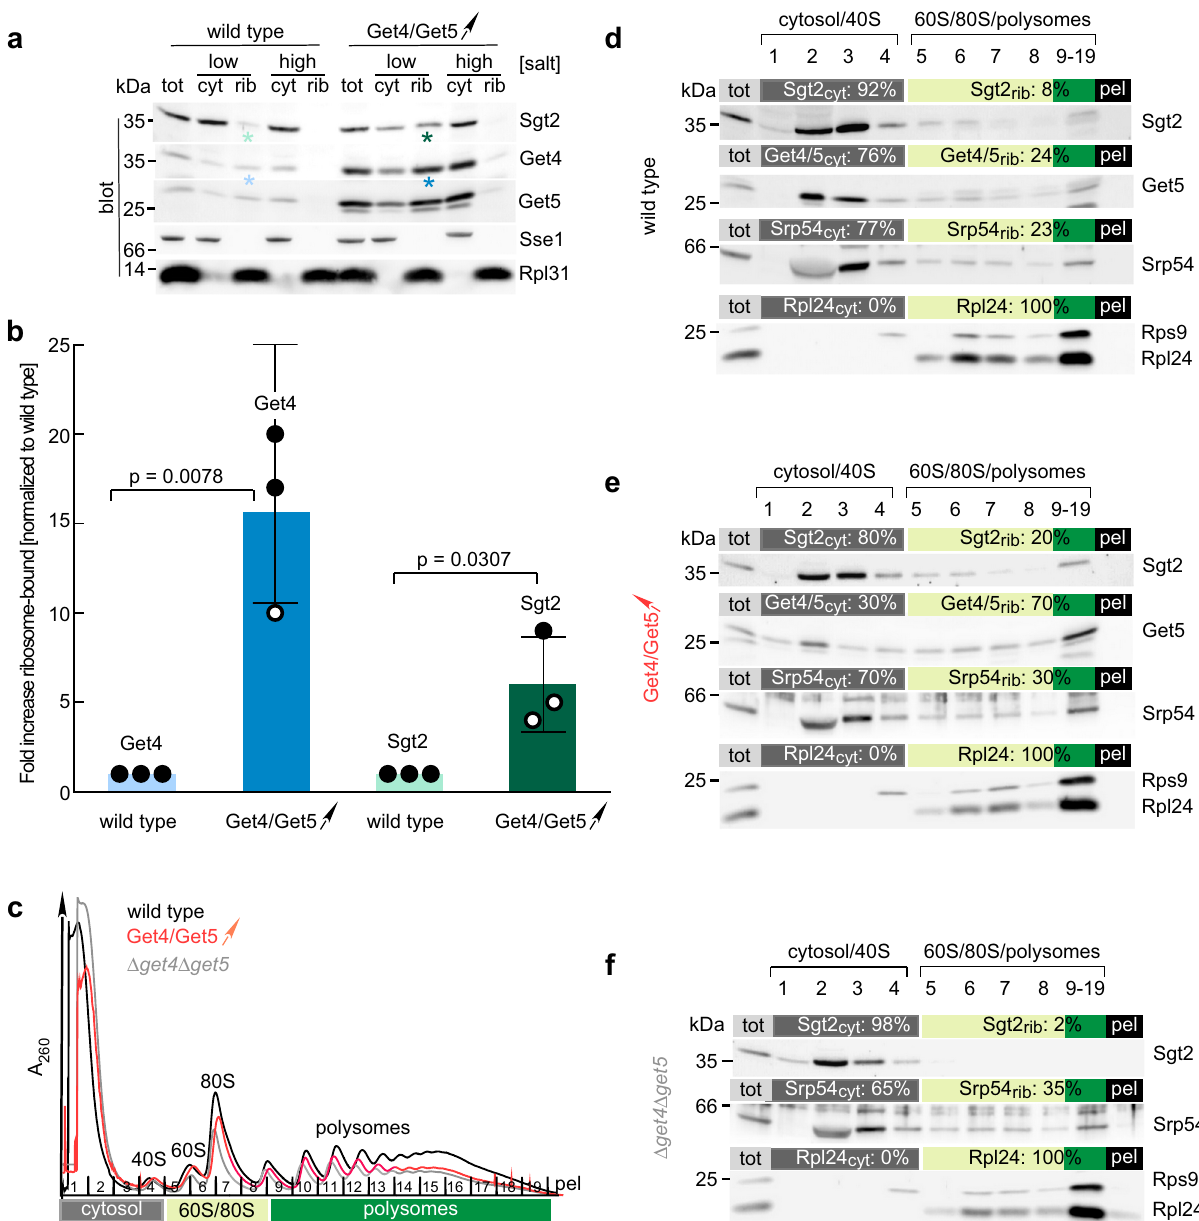
Fig. 6 Sgt2 is recruited to translating ribosomes via Get4/5 in vivo. a Sgt2 is associated with ribosomes in a Get4/5-dependent manner. Total cell extract (tot) of wild type or a strain overexpressing Get4/5 (Get4/Get5 ↑ ) was analyzed as described in Fig. 1a. Aliquots were analyzed by immunoblotting with α -Get4, α -Get5, α -Sgt2, α -Rpl31 (ribosomal marker), and α -Sse1 (cytosolic marker). Colored asterisks indicate the bands analyzed in b . b Ribosome occupancy with Sgt2 is enhanced upon overexpression of Get4/5. Ribosome-binding of Get4 and Sgt2 under low salt conditions was analyzed as in a . Shown is the mean (bars with standard deviation) of three independent experiments (dots). Values obtained for the wild type were set to 1. Indicated p values for Get4 or Sgt2 were calculated according to a two-sided Student ’ s t test using GraphPad Prism. The color code of the bars corresponds to the asterisks in a . c Ribosome pro fi le analysis reveals a sub-population of Sgt2 in polysome fractions, which depends on the presence of Get4/5. Sucrose density gradient centrifugation was performed with total cytosolic extract prepared from wild type (black), cells overexpressing Get4/Get5 (Get4/Get5 ↑ ) (red), or Δ get4 Δ get5 cells (light gray). Indicated in dark gray are the major cytosolic fractions and 40S particles (1 – 4), in light green (5 – 8) fractions containing 60S and 80S ribosomal particles, and dark green (9 – 19) polysome fractions. d – f Aliquots of individual fractions 1 – 8, pooled fractions 9 – 19, and the pellet fraction at the bottom of the gradient tube (pel) (see c ) were analyzed via immunoblotting with α -Sgt2, α -Get5, α -Srp54, the 40S subunit ( α -Rps9), and the 60S subunit ( α -Rpl24) (for details see Methods). The total (tot) corresponds to 5% of the cytosolic extract loaded onto the gradient. The distribution of ribosome-bound factors between cytosol and ribosomes was estimated as follows. Intensities of immunostained bands in fractions 1 – 19 (100% = total intensity of fractions 1 – 19) was determined for each ribosome-bound factor. The percentage of each ribosome-bound factor in the cytosolic fractions 1 – 4 (cyt: %) and in the ribosomal fractions 5 – 19 (rib: %) was calculated relative to the total. The color code is as in c .